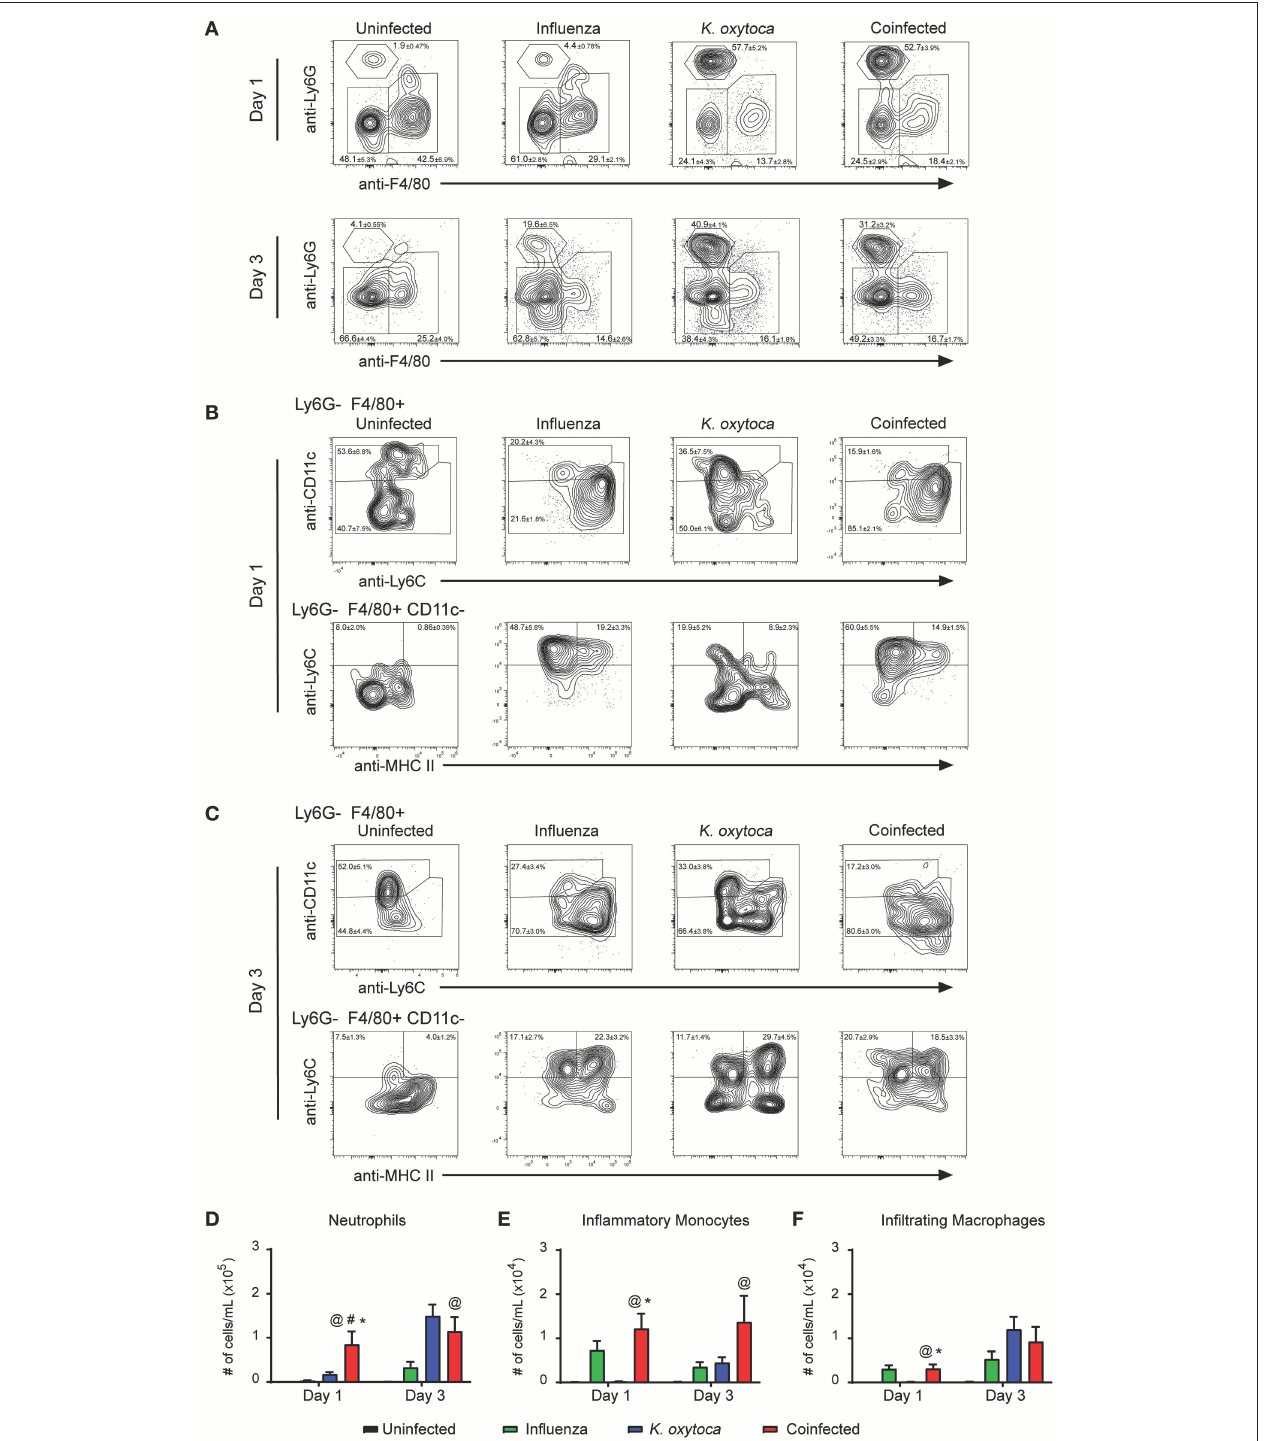
FIGURE 3 | Immune cell infiltrate is increased in the lungs of coinfected mice. Innate immune cell populations were quantified in the lungs of mice on days 1 and 3 post- K. oxytoca infection. We identified neutrophils as Ly6G + F480 − cells and separated the F480 + population according to expression of CD11c with alveolar macrophages and repopulating macrophages identified as Ly6G − F480 + CD11c + cells. The CD11c − population was further separated by expression of Ly6C and MHC II with inflammatory monocytes identified as Ly6G − F480 + CD11c − Ly6C + MHC II − cells and infiltrating macrophages identified